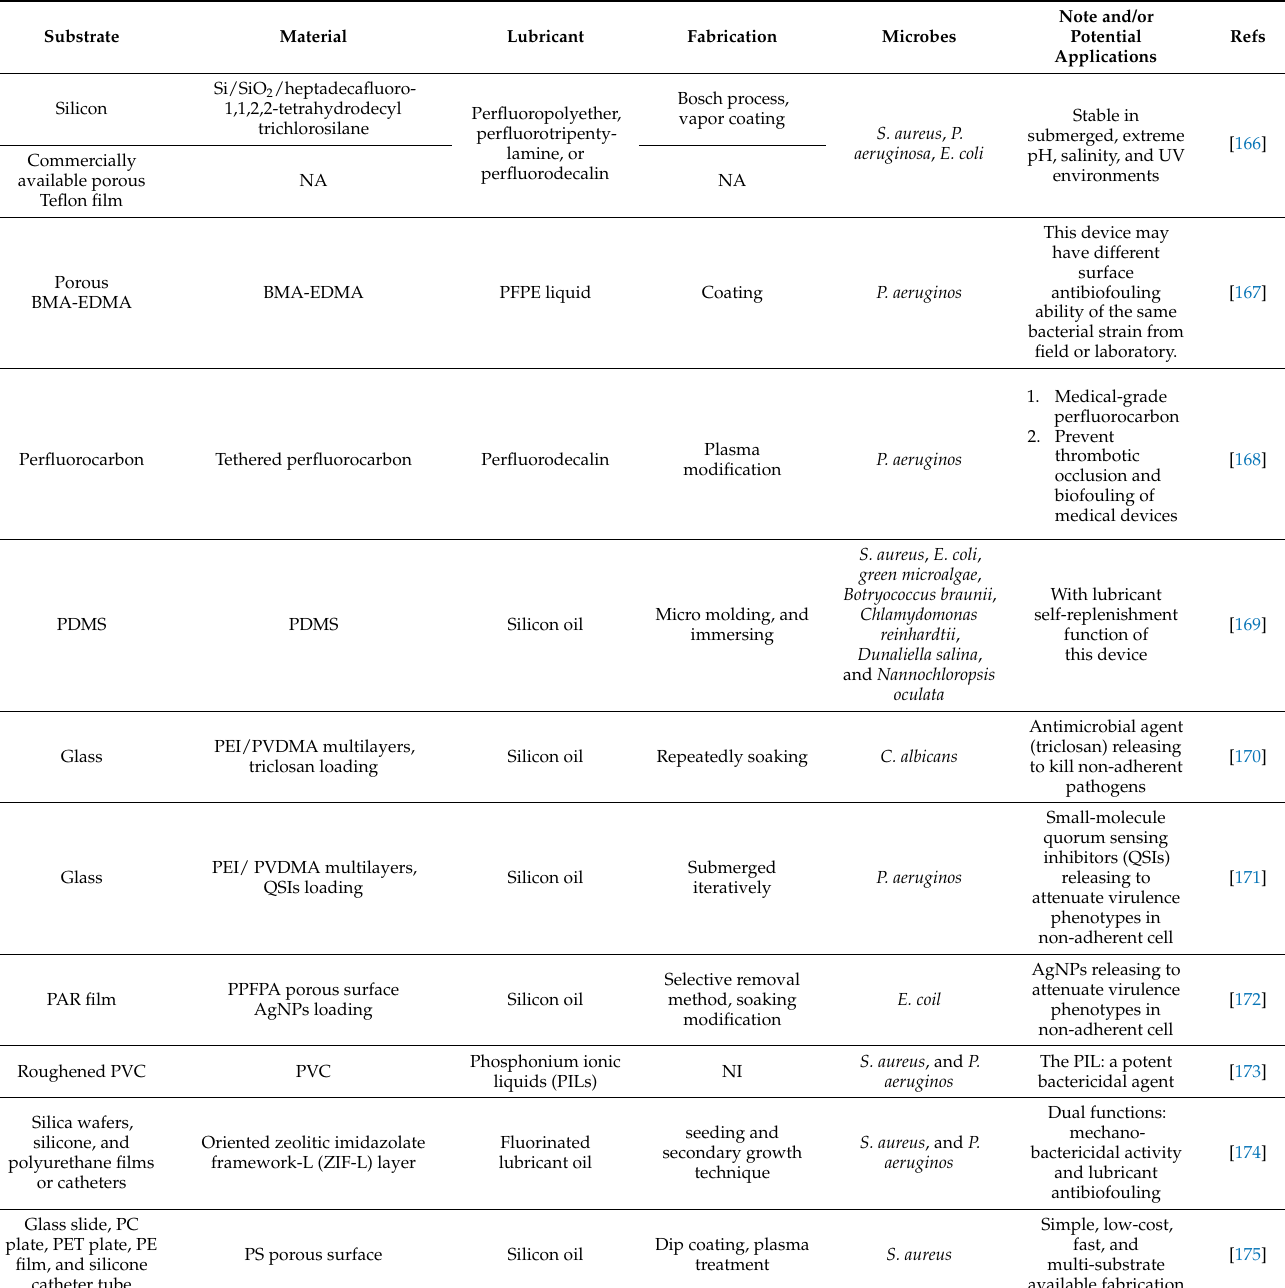
Table 3. Summary of slippery